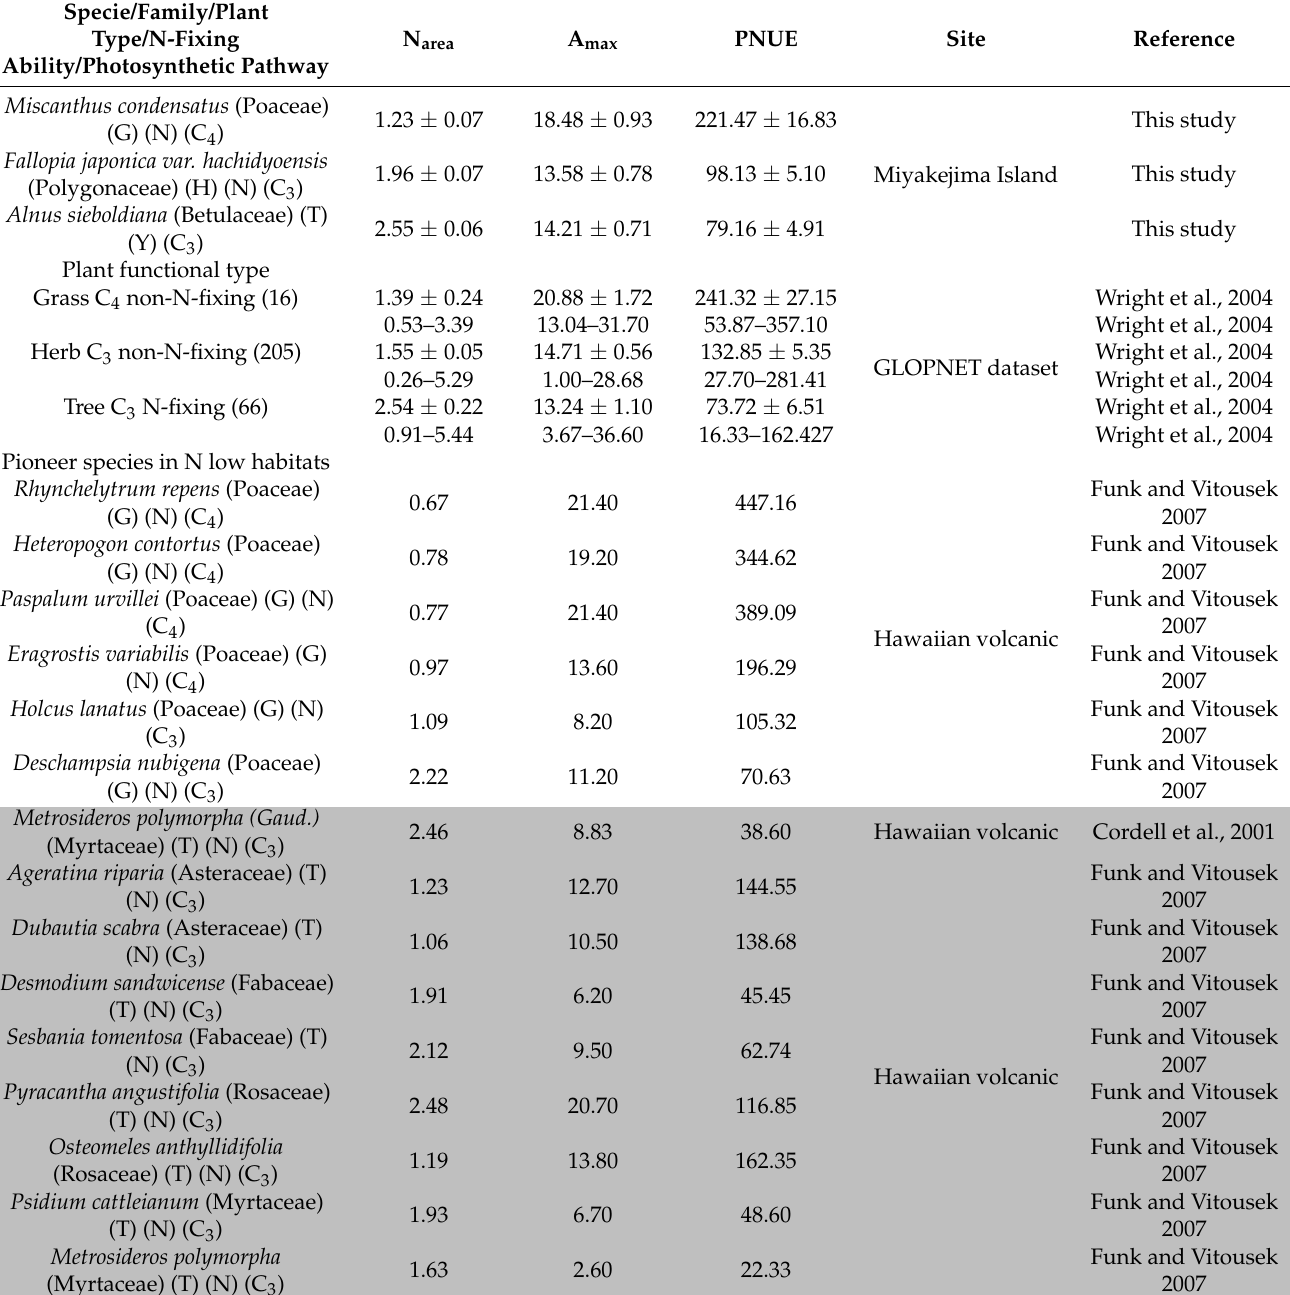
Table A1. Comparison of leaf trait values (mean ± SE) among the three pioneer species ( n = 15 for each species) (this study) collected from the volcanically devastated site on Miyake-jima Island with the data of same functional type leaves from the GLOPNET dataset (range and mean ± SE) (Wright et al., 2004) and the leaf traits values (mean ± SE) of other pioneer species living in similar habitat conditions. Life form, grass (G), tree (T), herb (H); N-fixing ability, yes (Y), no (N); photosynthetic pathway, C 3 and C 4 . Traits, N area , leaf nitrogen content per area (g · m − 2 ); A max , light saturated photosynthetic rate per